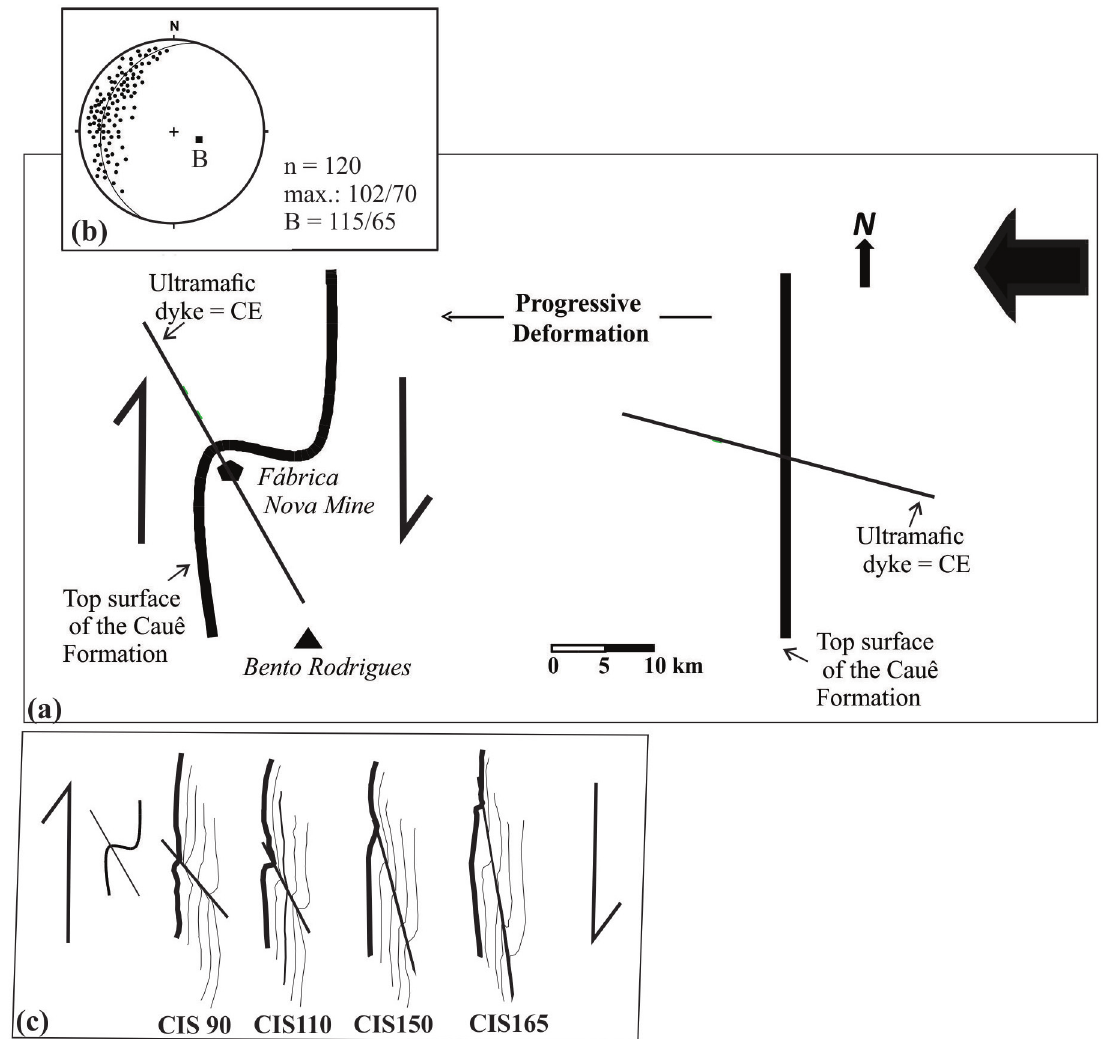
Figure 9 - ( a ) Schematic map representing the top surface of the Cauê Formation (Quadrilátero Ferrífero) before and after the formation of the flanking fold (modified from Rossi and Endo 2015). CE = cross-cutting element. The thick arrow indicates the sense and direction of the Brasiliano shortening event. ( b ) Structural data from the Fábrica Nova region: stereoplots refer to the orientation of the poles of the bedding planes of the Cauê Formation (n = number of measurements, B = average orientation of flanking fold axis. ( c ) Comparison of the flanking fold of the Cauê Formation and the line drawings of the final flanking structures of the models CIS90, CIS110, CIS150 and CIS165 with layer (1) shown in